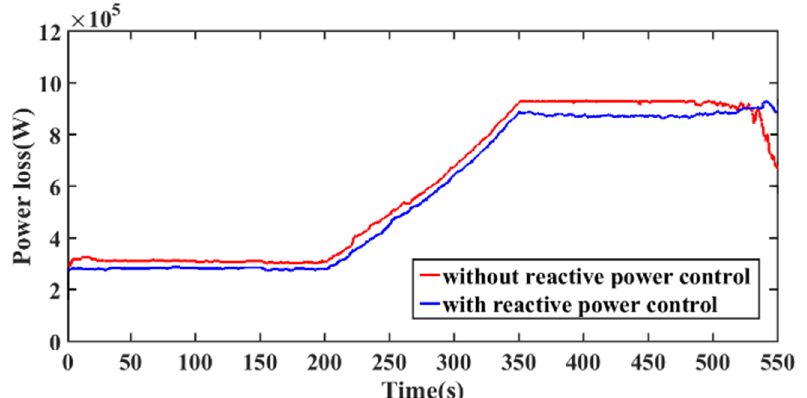
Figure 17. Network power losses of wind farm.